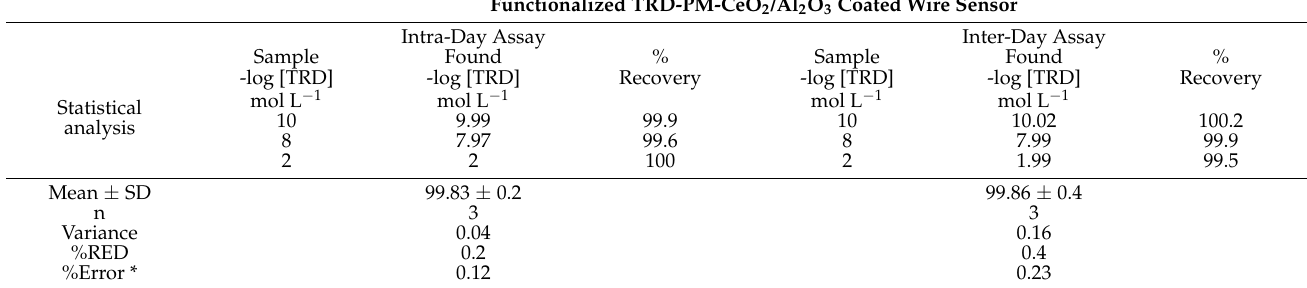
Table 5. Precision (inter-day and intra-day assays) results for the determination of TRD samples by using conventional and functionalized TRD-PM and TRD-PM-CeO 2 /Al 2 O 3 nanocomposite coated wire sensors.